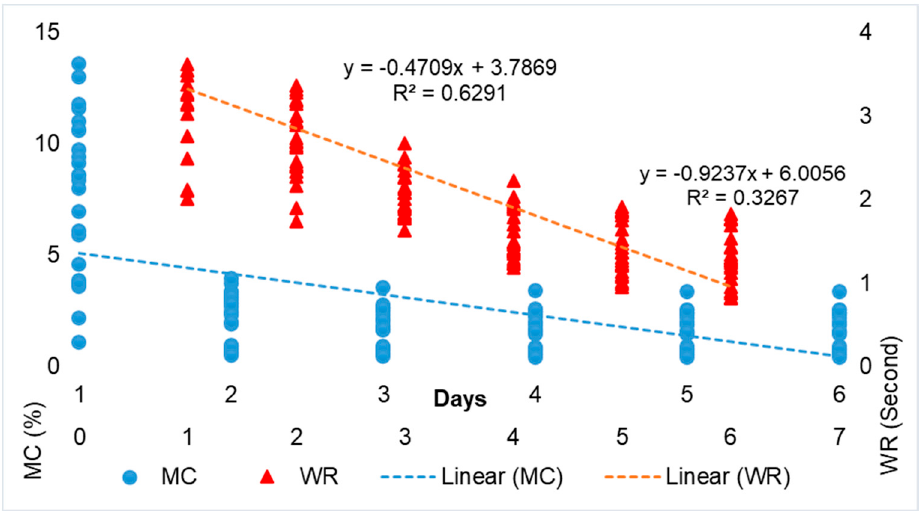
Figure 10. Combined temporal effect on moisture content (MC) vs. water repellency (WR) in biochar- amended soil from day 1 to day 6.